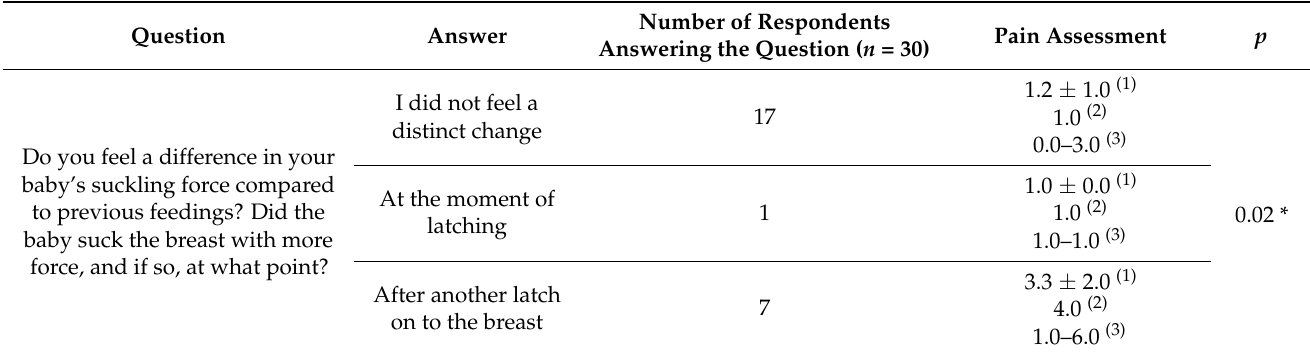
Table 5. Relationship between pain assessment and the answer to question no. 3.